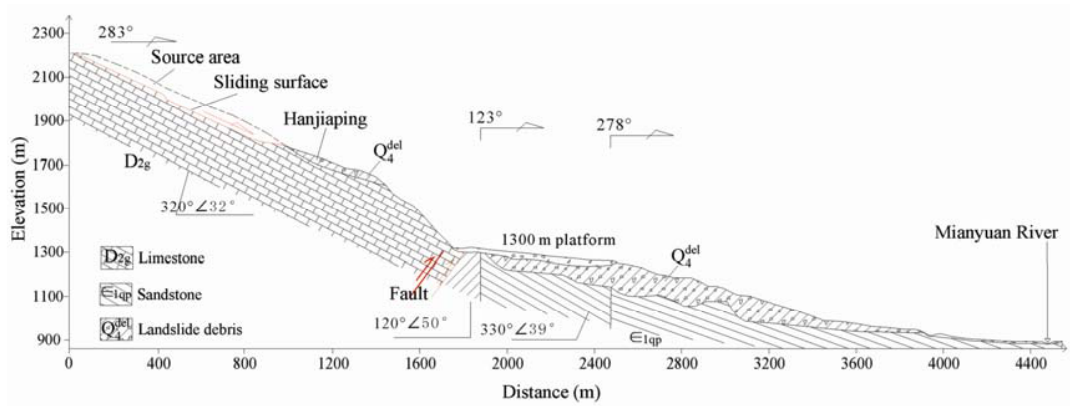
Fig. 5. Section of the Wenjia gully landslide (Huang and Zhao, 2010).